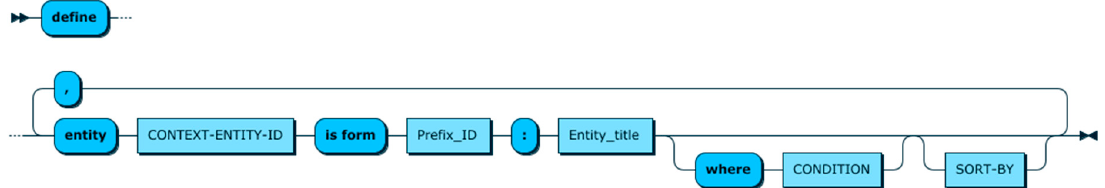
Figure 10. DEFINE clause production rule.